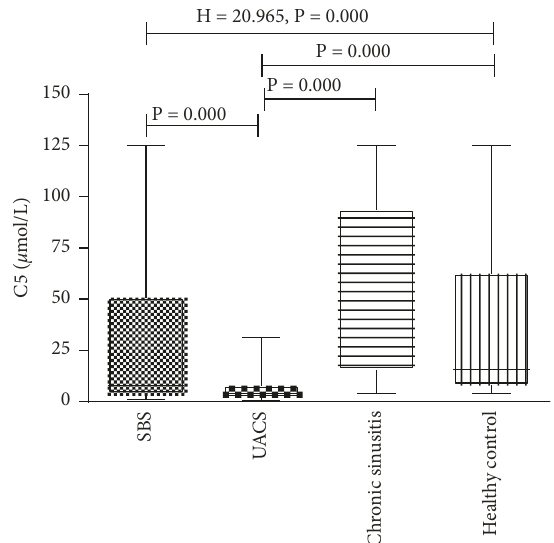
Figure 2: Cough sensitivity for each